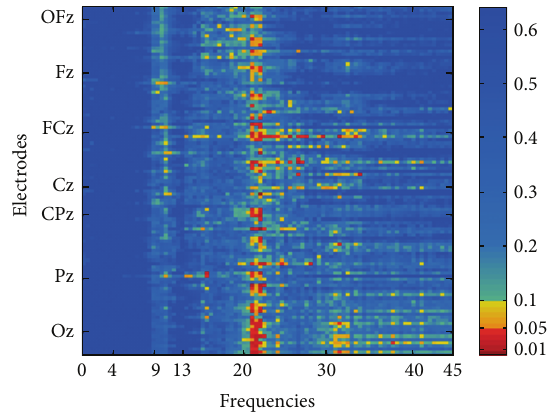
Figure 2: Comparison of TI versus CO normalized EEG spectral power adjacency matrix of the group comparison (TI versus CO): significance levels ( 𝑃 values) of the correlations are color-coded (one-sided). On the 𝑦 -axis electrodes are aligned from rostral (top) to caudal (bottom), irrespective of laterality. Positions of electrodes on the central line are